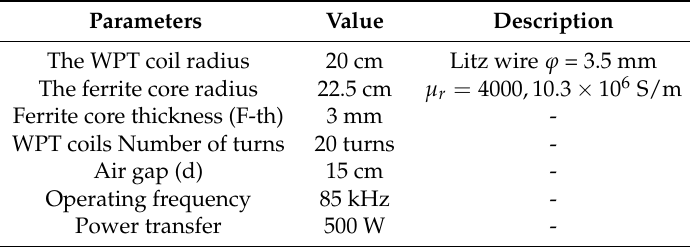
Figure 6. Wireless power transfer (WPT) system pad structure in the presence of ferrite cores. The simulation parameters are presented in Table 1. Table 1. The simulation design